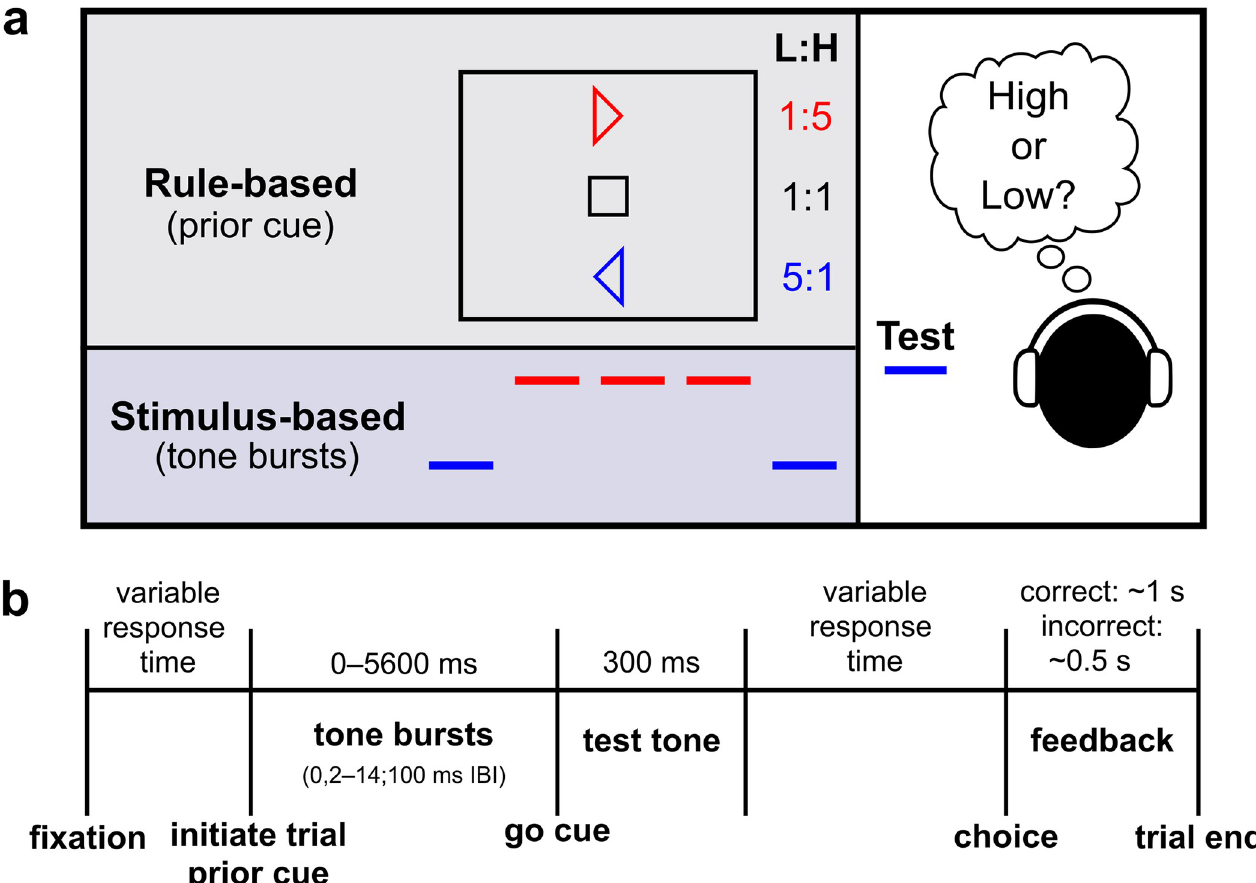
Fig 1. Task structure. A Subjects indicated with a button press whether a test tone was “high” frequency or “low” frequency. In the rule-based condition, the test tone was preceded by a visual stimulus (prior cue) that indicated the probability that the upcoming tone would be low (L) or high (H) frequency, with the probability determined by the L:H ratio. In the stimulus-based condition, the test tone was preceded by a variable-length, temporal “pre-test” sequence of low- and high-frequency tones. On average, this sequence was not predictive of the test tone. In the mixed conditions, subjects received both rule-based and stimulus-based cues on each trial. B Detailed trial timing. After attaining fixation, the subject initiated the trial with a button press. The subject was then able to report their decision with a second button press at any time following the “go cue” (up to 2000–3000 ms).